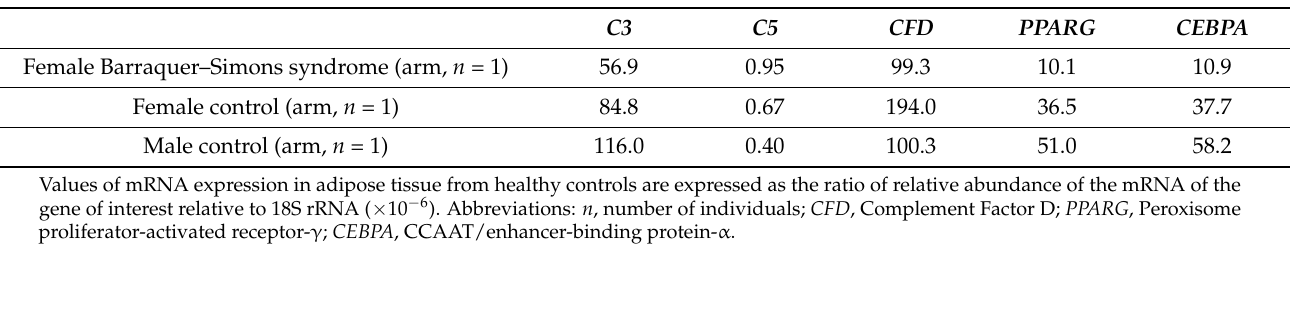
Figure 3. Correlation of plasma FD levels with age. Age positively correlated with FD levels from controls ( A ), patients with Barraquer–Simons syndrome (BSS) ( B ), patients with C3 glomerulopathy (C3G) ( C ), but not in patients with acquired generalized lipodystrophy (AGL) ( D ). These correlations were calculated using the Spearman Rank correlation coefficient. Females are indicated by circles and males by triangles. p < 0.05 was considered to be statistically significant. Table 2. mRNA expression levels of genes of the complement system and adipogenesis pathway in subcutaneous adipose tissue samples from a patient with Barraquer–Simons syndrome and healthy